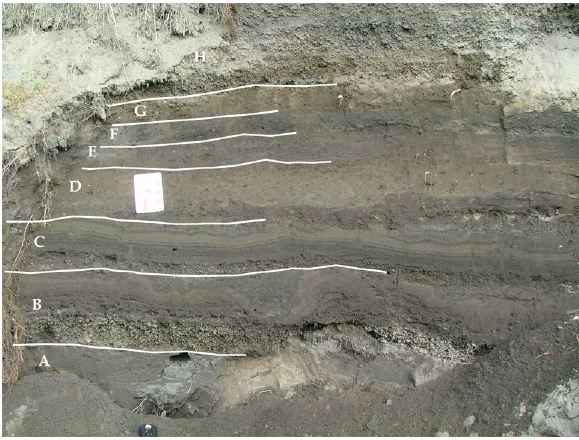
Figure 2. The depositional features of SMM eruption cycle at S1 (Villa Telesi stratigraphic section). Fa, fine-grained ash; Ca, coarse- grained ash; Fl, fine-grained lapilli; Cl, coarse-grained